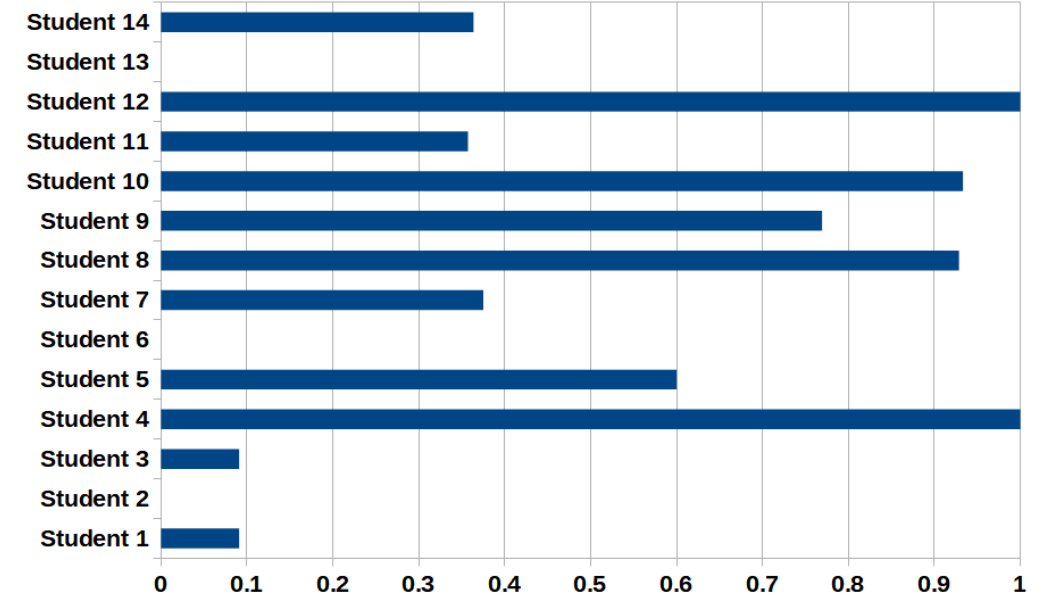
Figure 13: Presentation of paper